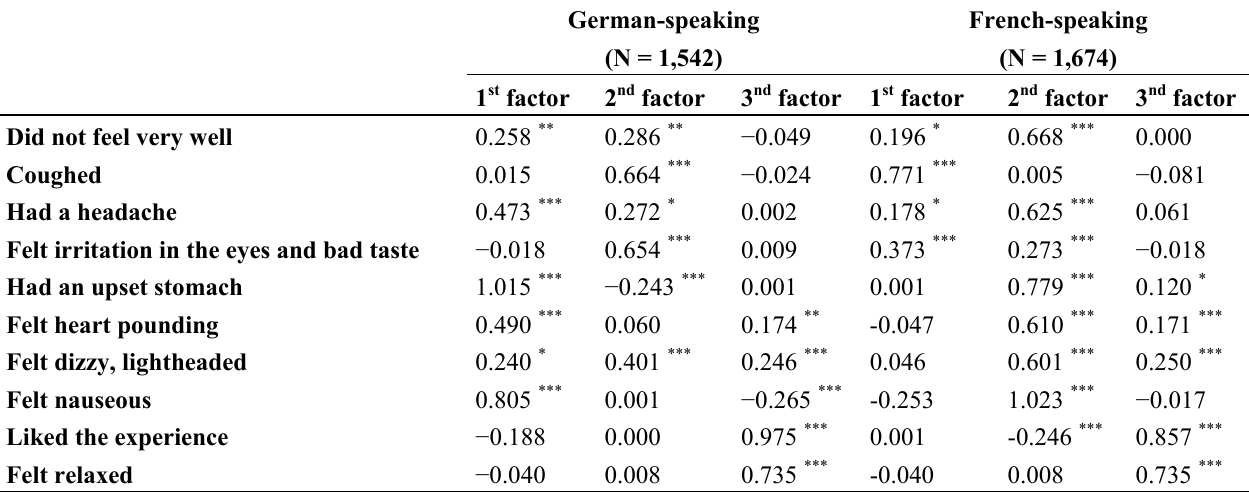
Table 2. Loadings for final ESEM three-factor model with configural invariance.